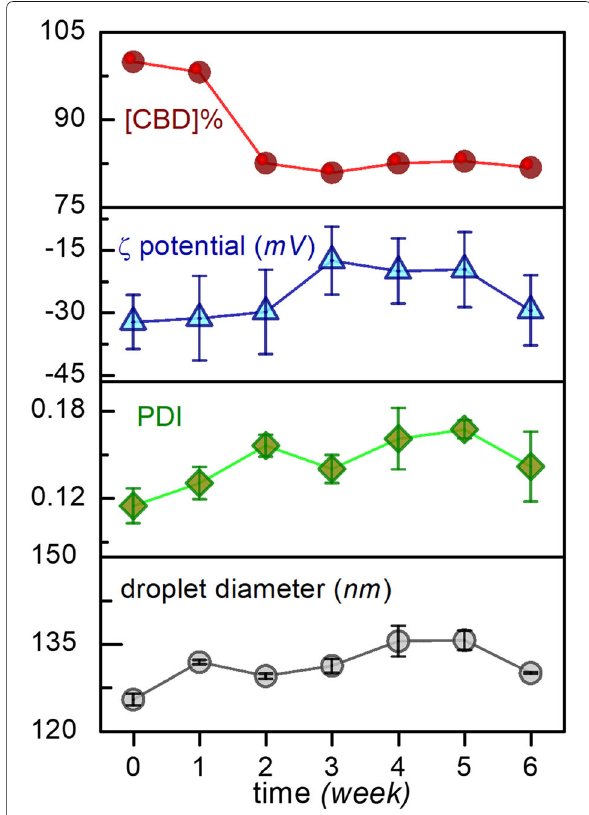
Fig. 7 Variation of CBD concentration (as a % of measured CBD used in nanoemulsion preparation) in the nanoemulsion, zeta potentials,